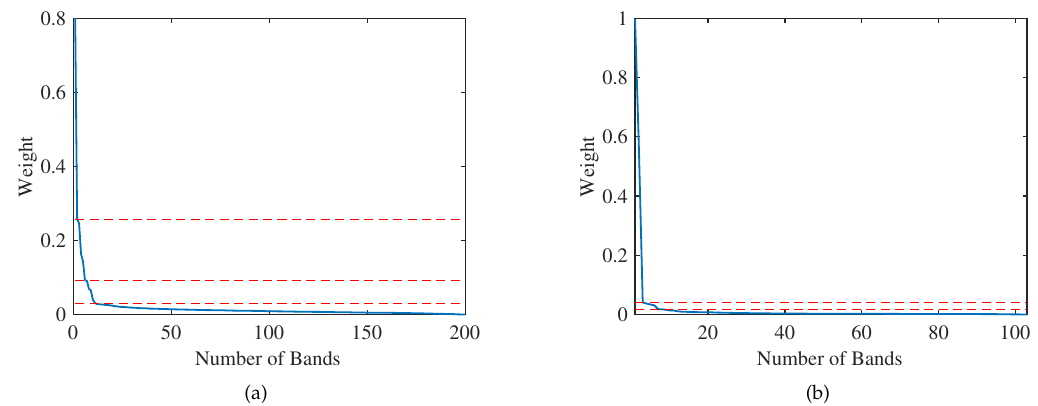
Figure 4. Band weight curve. ( a ) Band weight curve on Indian Pines data set. ( b ) Band weight curve on Pavia University data set.